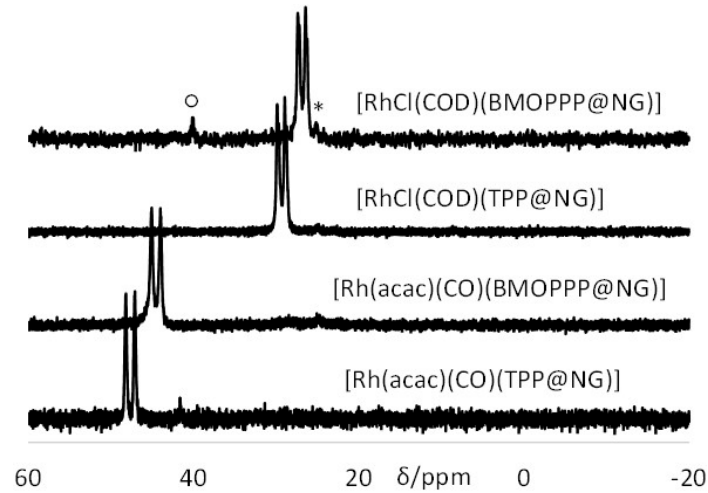
Figure 5. 31 P{ 1 H} NMR spectra of TPP@NG and BMOPP@NG 100% loaded with [Rh(acac)(CO) 2 ] or [RhCl(COD)] 2 in water after swelling with toluene. The starred resonance corresponds to a small amount of oxidized phosphine. The resonance marked with a circle belongs to an unknown impurity. Table 2. 31 P{ 1 H} NMR properties of the 100% Rh-loaded polymers.